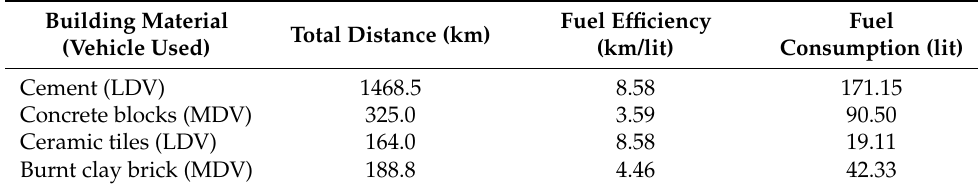
Table 4. Fuel consumption for the material